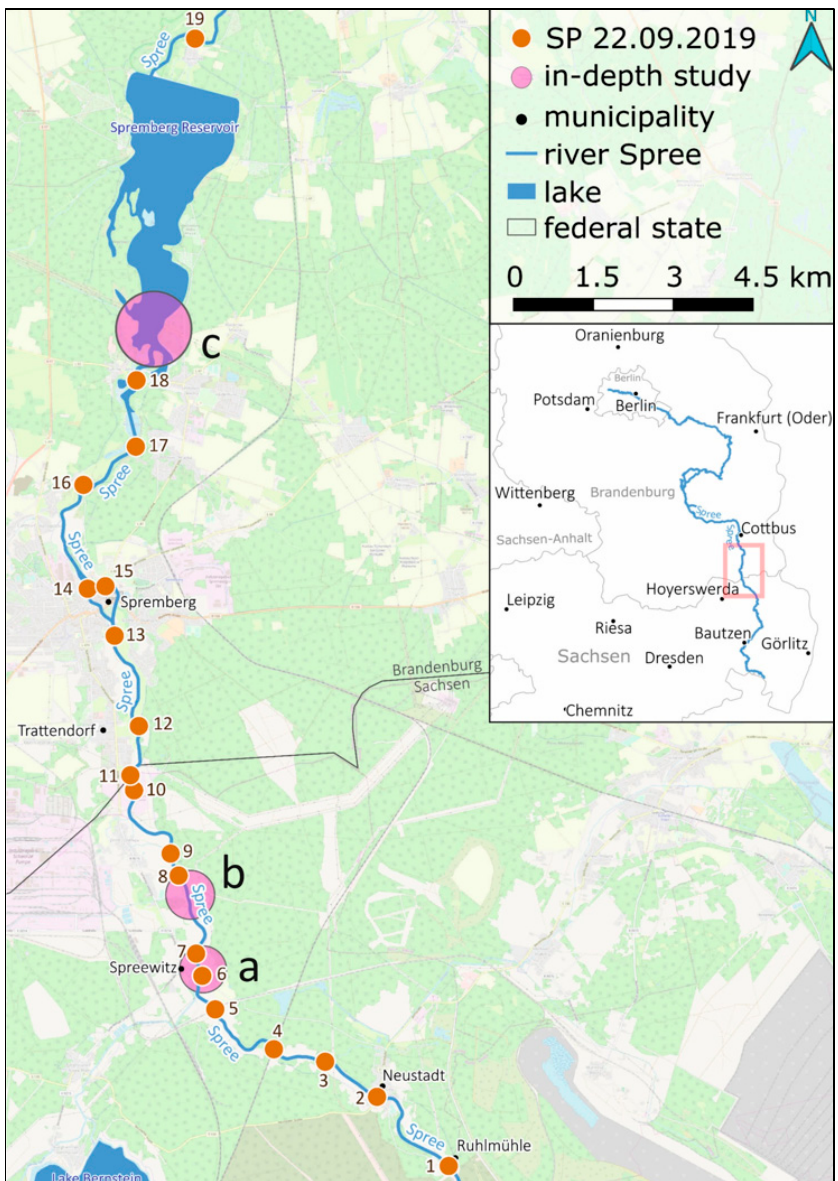
Figure 1. Study site in the south-east of Berlin in Lusatia along the Spree River from the Ruhlmühle village to the Spremberg reservoir. The flow direction of the Spree from south to north. (a–c) shows the sites for more in-depth studies.